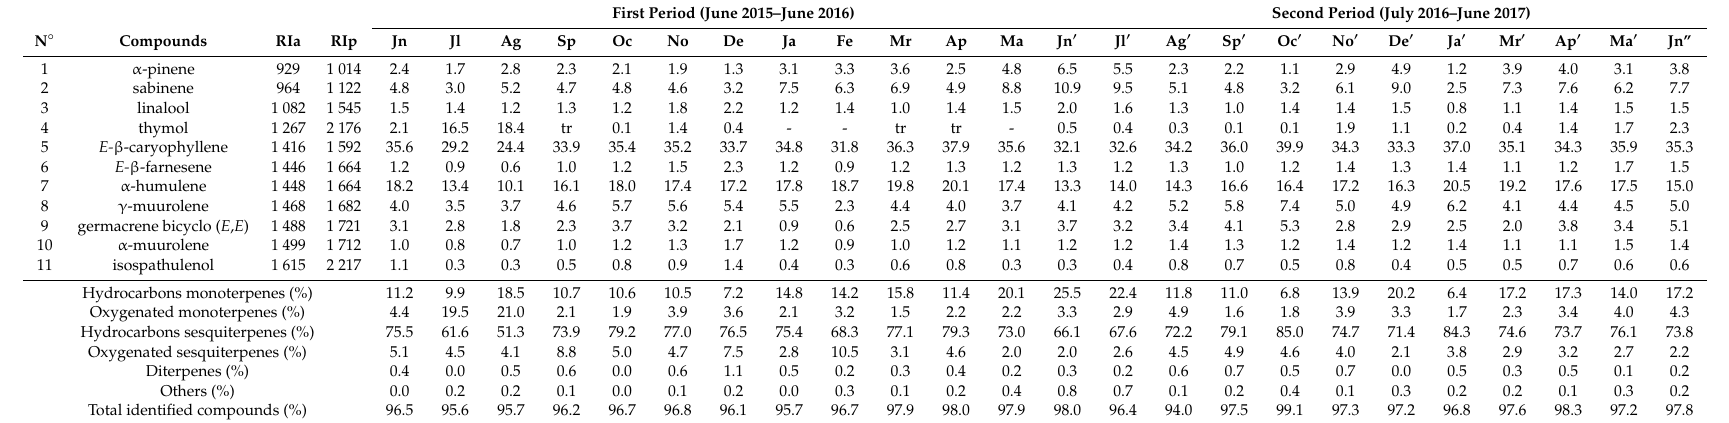
Table 1. Major compounds and total identified compounds in leaves’ essential oils of Lantana camara from